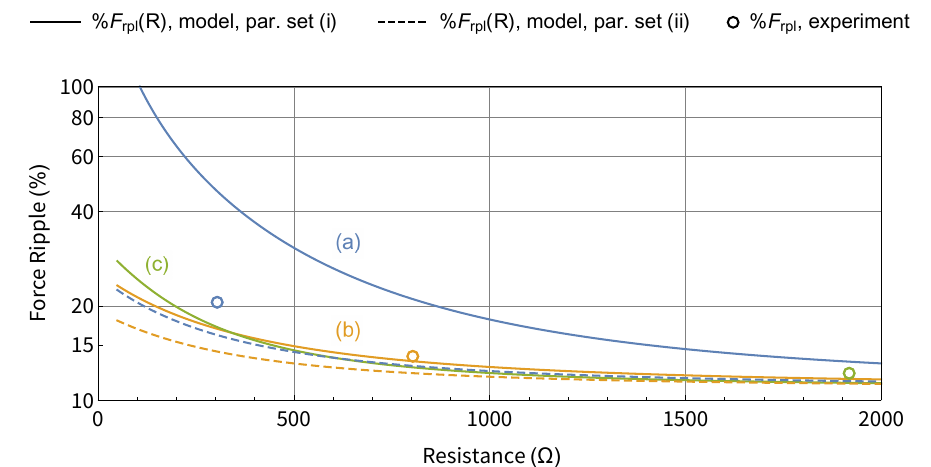
Figure 9. Force ripple measurements compared to values obtained from the model under different conditions.